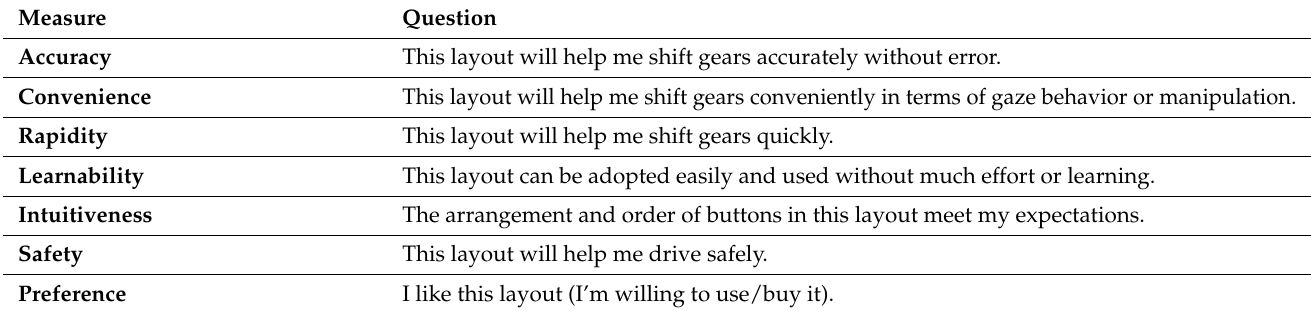
Table 5. Seven subjective rating measures and corresponding